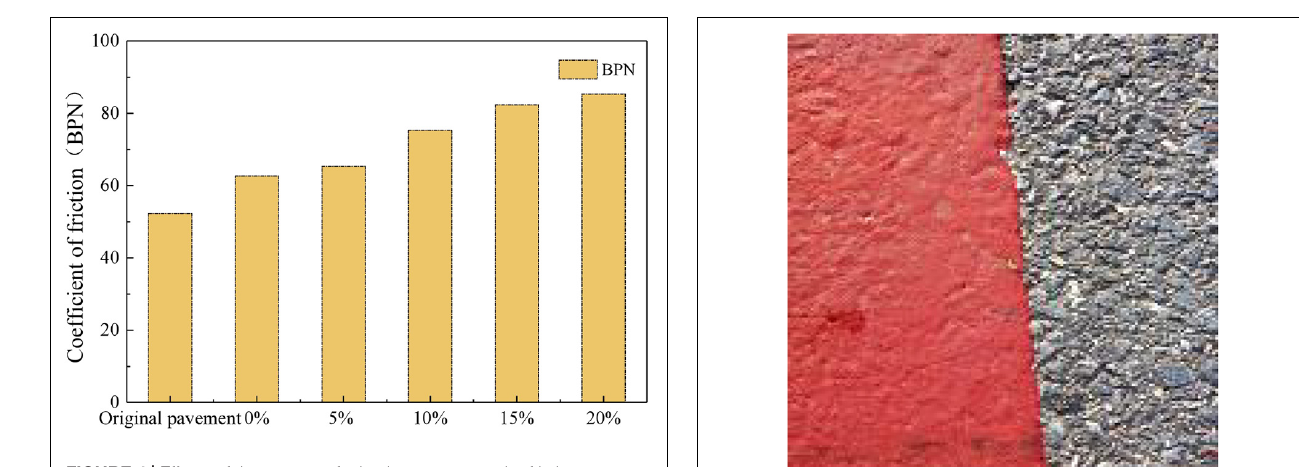
FIGURE 4 | Effects of the amount of mixed aggregate on the friction pendulum value of the seal pavement.